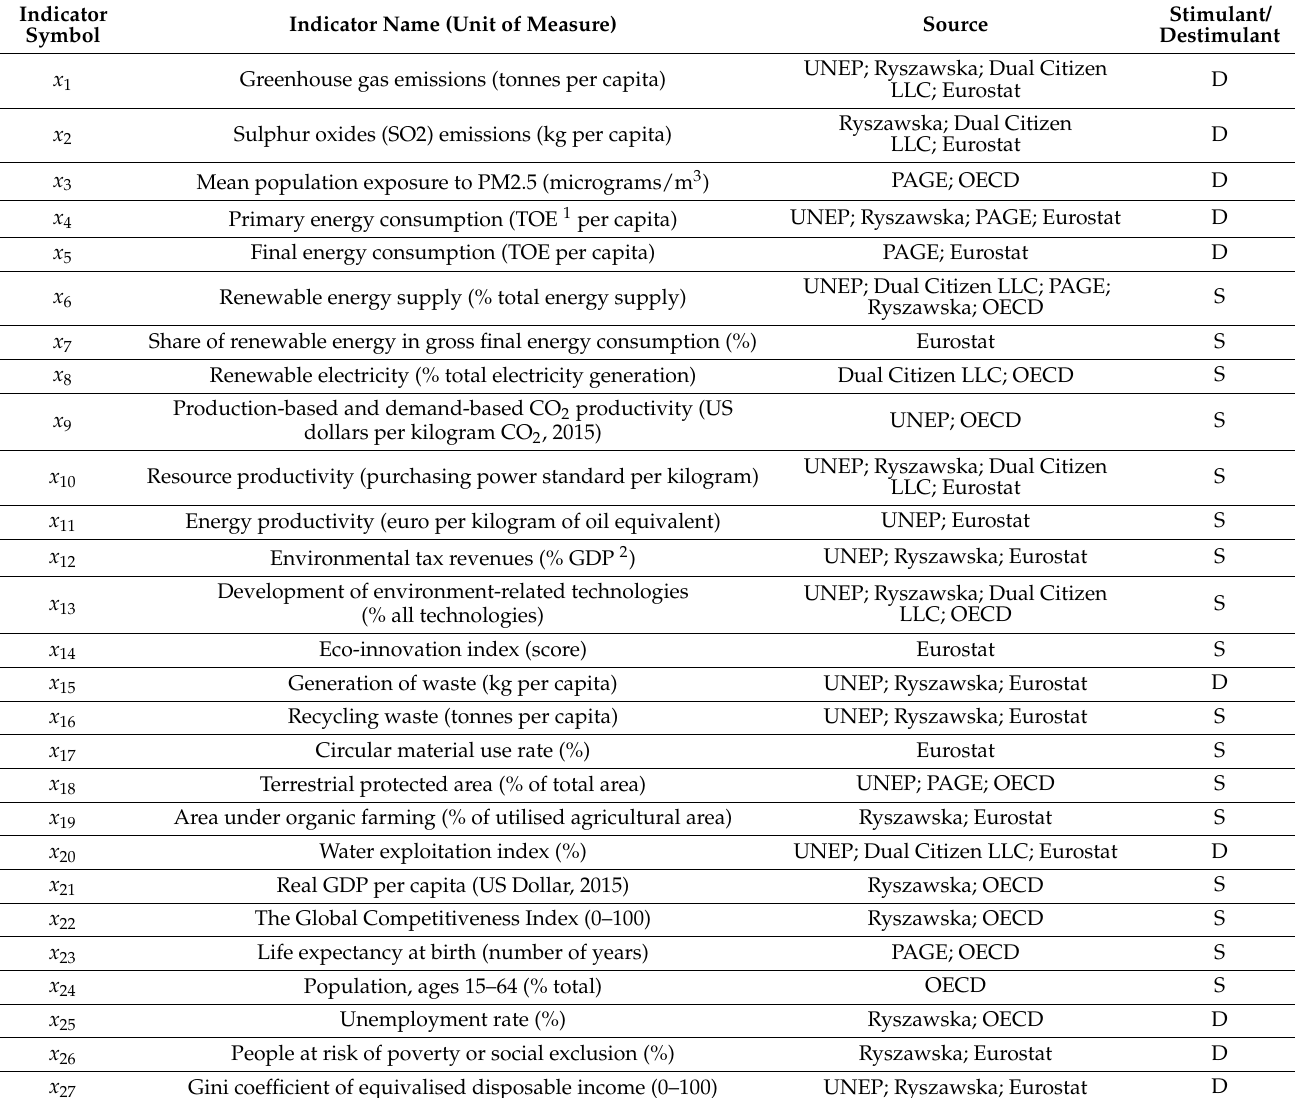
1 TOE—tonne of oil equivalent; 2 GDP—gross domestic product. Source: own elaboration based on: UNEP, 2012; Ryszawska, 2013a; PAGE, 2017; Dual Citizen LLC, 2018; the OECD and Eurostat